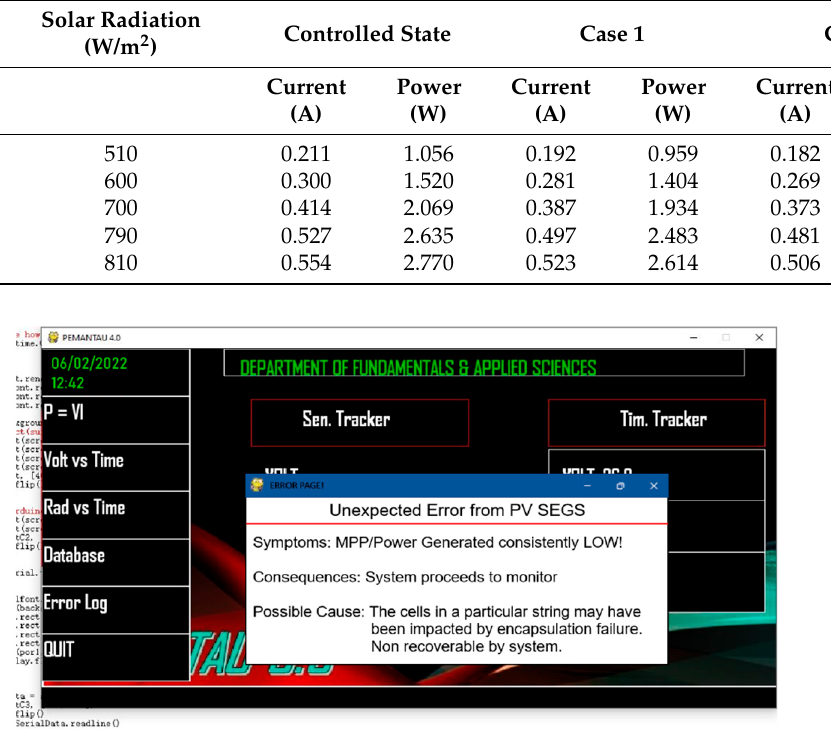
Figure 9. Error page showing detection of encapsulation failures.